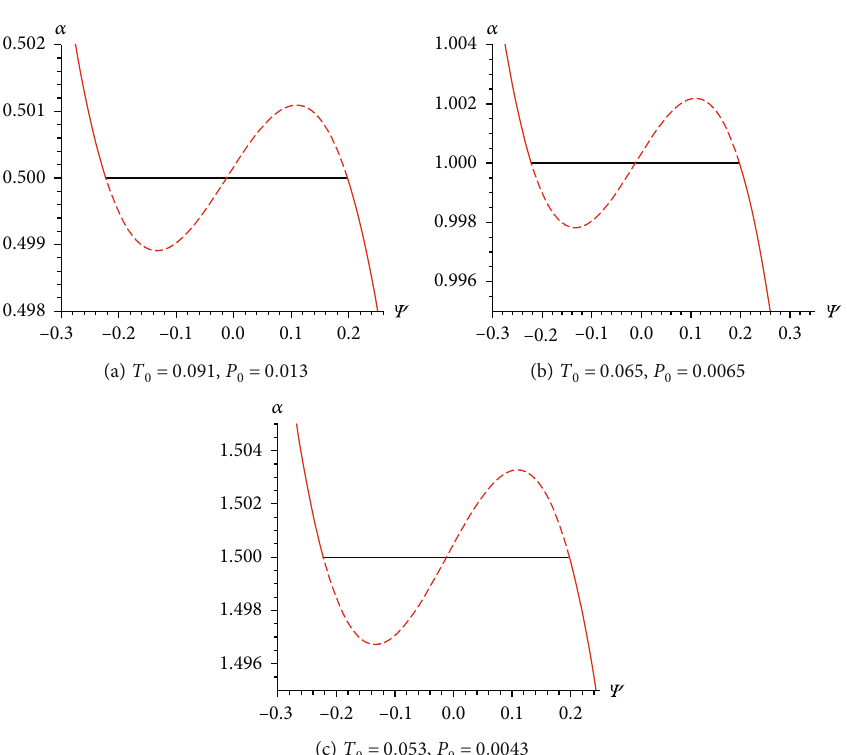
Figure 3: The α − Ψ curves of the Einstein-Gauss-Bonnet AdS black hole phase transition with the same temperature, pressure, and the radio parameter x = r 1 / r 2 = 0 : 7 .